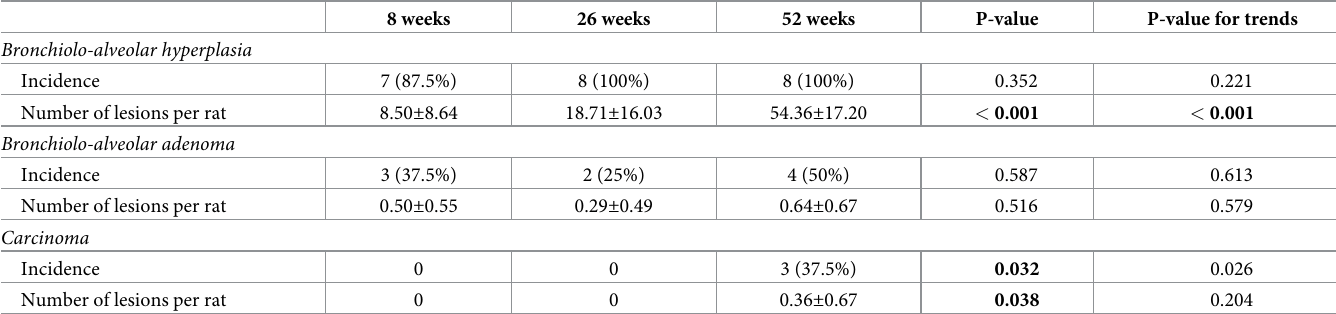
Table 2. The incidence and number of bronchiolo-alveolar hyperplasia and tumors after PHMG exposure.